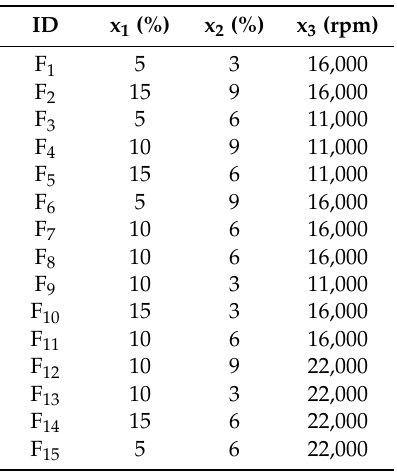
Table 2. Experimental planning according to Box-Behnken